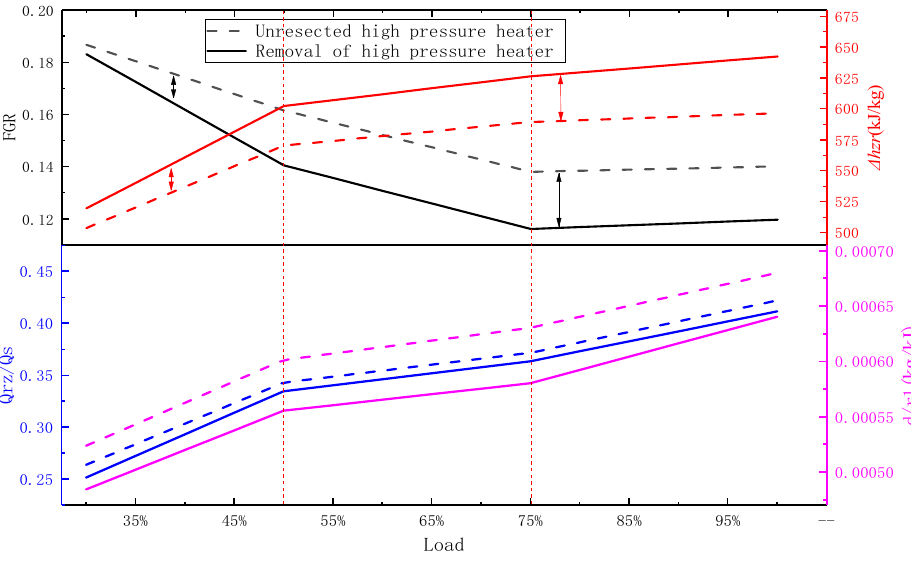
Figure 12. E ff ect of feed water temperature on di ff erent parameters under di ff erent Figure 12. Effect of feed water temperature on different parameters under different loads.